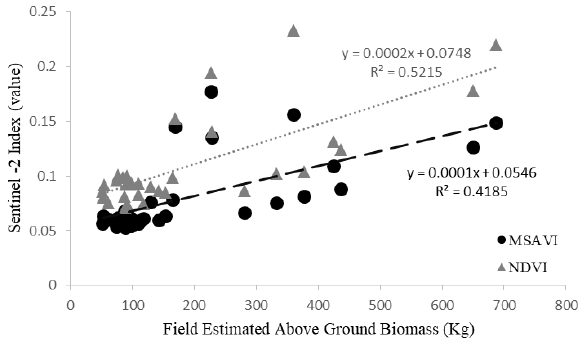
Figure 5. Relationships of field estimated above-ground biomass with Sentinel-2 derived vegetation indices as NDVI and MSAVI for each